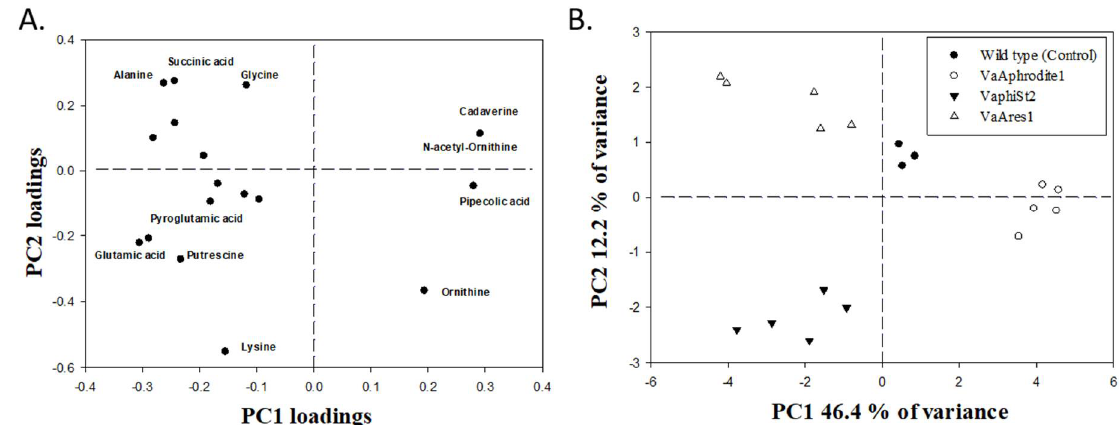
Figure 4. Partial Least Squares Discriminant Analysis (PLS-DA) of metabolomics results. and representation of component 1 (46.4%) and component 2 (12.2%) ( A ) of the identified metabolites discussed in the results and discussion section comparing the wild type (Control, phage-susceptible strains; n = 4), VaAphrodite1 strains (phage strains resistant to bacteriophage Aphrodite1; n = 5), VaphiSt2 strains (phage strains resistant to bacteriophage phiSt2; n = 5), and VaAres1 strains (phage strains resistant to bacteriophage Ares1; n = 5). ( B ) Loadings of individually identified components showing the highest variability under the studied experimental conditions. Table 6. Average relative response of intracellularly detected compounds and their respective retention time, mass charge ratio, and p -value (ANOVA, post-hoc Student’s t -test, <0.05; Control n = 4; Resistant strains n = 5). Bold values represent statistical significance. RT